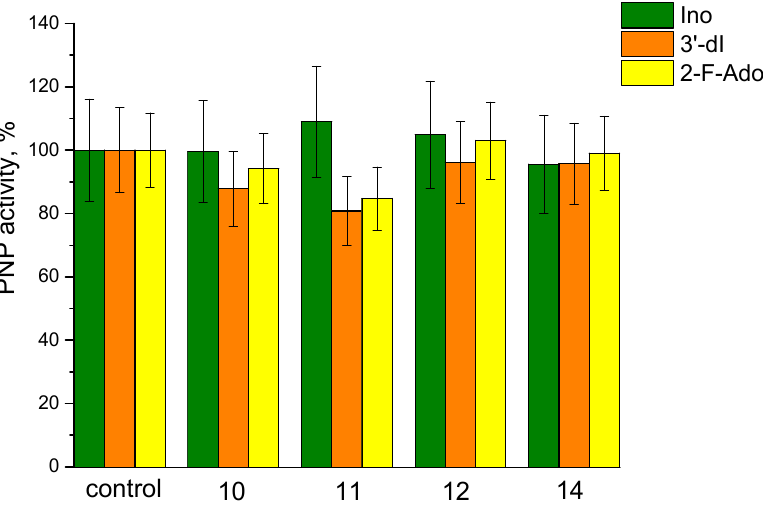
Figure 12. PNP activity for inosine (green), 3 ′ -deoxyinosine (orange), and 2-fluoroadenosine (yellow) phosphorolysis in the presence of compounds 10 , 11 , 12 , and 14 . It can be seen that neither compound 11 nor compounds formed from 11 affect E. coli PNP activity.